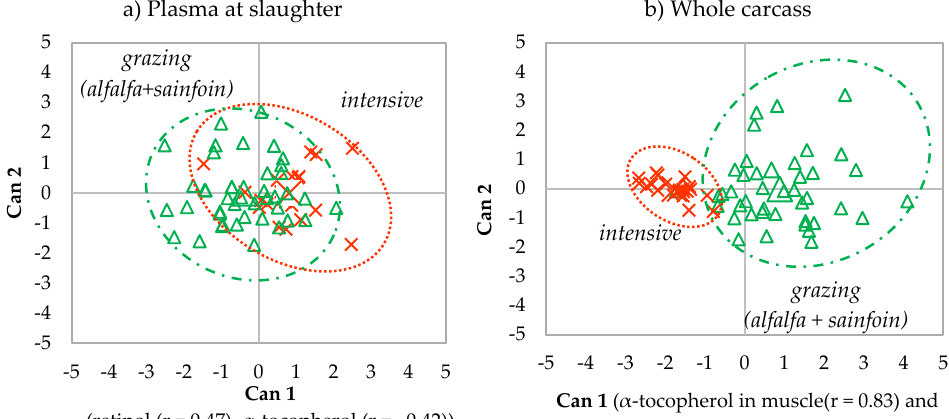
Figure 5. Canonical discriminant plots between maternal feeding (intensive vs. grazing) in the plasma at slaughter ( a ), whole carcass ( b ), liver ( c ), muscle ( d ), perirenal ( e ) and subcutaneous fat ( f ) using the analytes determined in each tissue. 4. Discussion 4.1. Carotenoids and Tocopherols in the Feedstuffs The high content of the main carotenes, xanthophylls and α-tocopherol, found in the fresh alfalfa and sainfoin but low or undetectable content found in the TMR and concentrates is in agreement with previous studies that looked at fresh and preserved forages and concentrates [7,8,26].